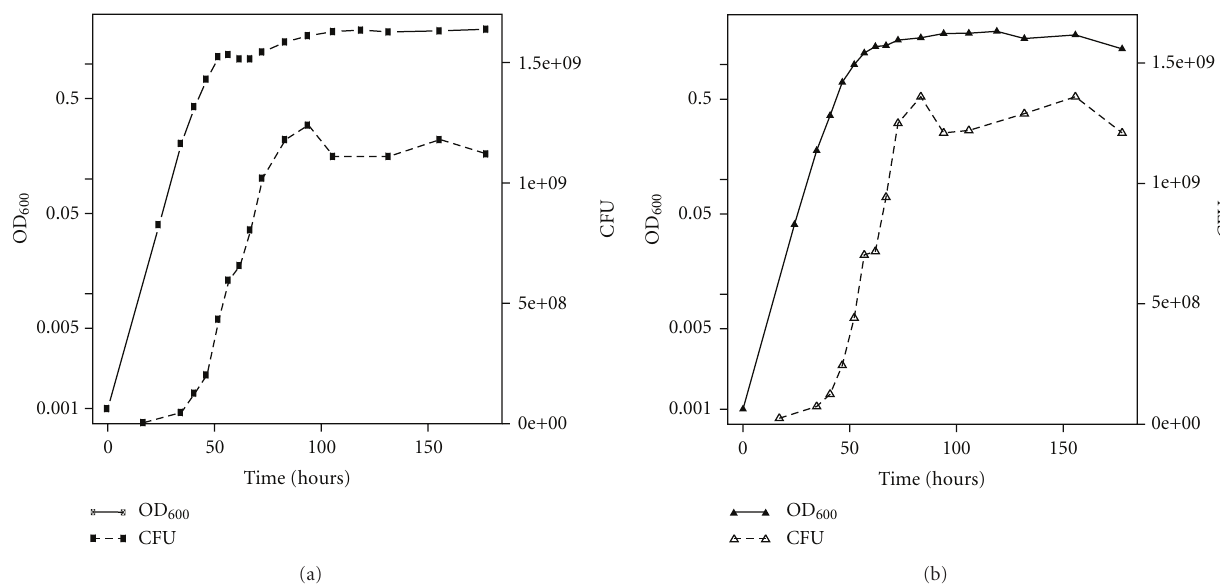
Figure 3: Growth of Halobacterium salinarum NRC-1 wild-type and GV deficient strains. Halobacterium salinarum NRC-1 wild-type and GV deficient strains were grown in triplicate as described in Materials and Methods. Growth was measured by light scattering at 600 nm (filled shapes) and by counting colony forming units using the spread plate technique (open shapes). OD 600 is reported against the left y -axis in logarithmic scale and CFU is reported against the right y -axis in linear scale. (a) Growth of wild-type NRC-1 and (b) growth of GV deficient